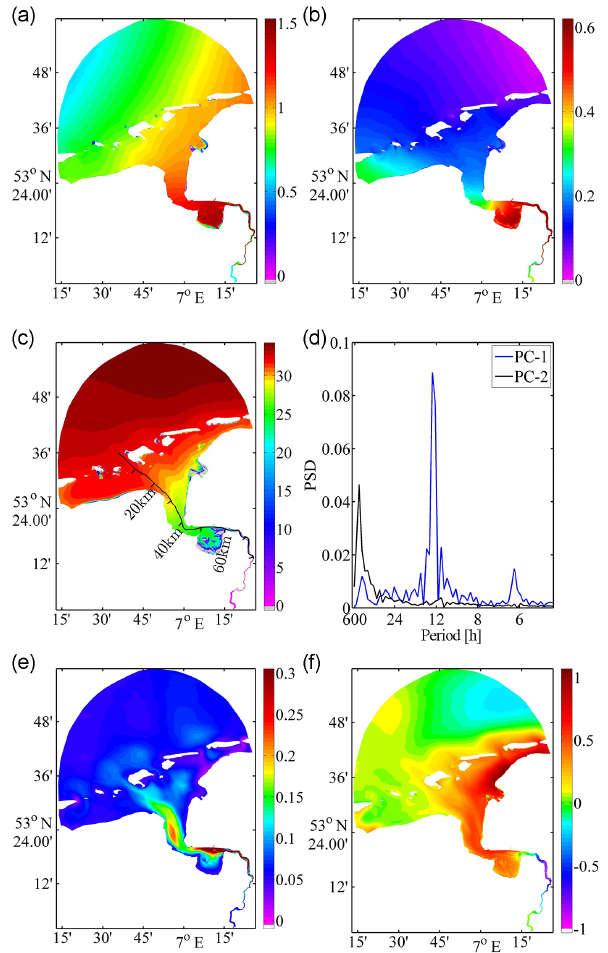
Figure 7. Amplitude of M2 (a) and M4 (b) tides in meters. (c) Ver- tically and time-averaged salinity (psu) during one neap–spring pe- riod (replotted from Pein et al., 2016). (d) Spectral analysis of the first and second PCs. (e) First and (f) second EOFs of surface salin- ity. The transect line in (c) is where some analyses of model simu- lations are